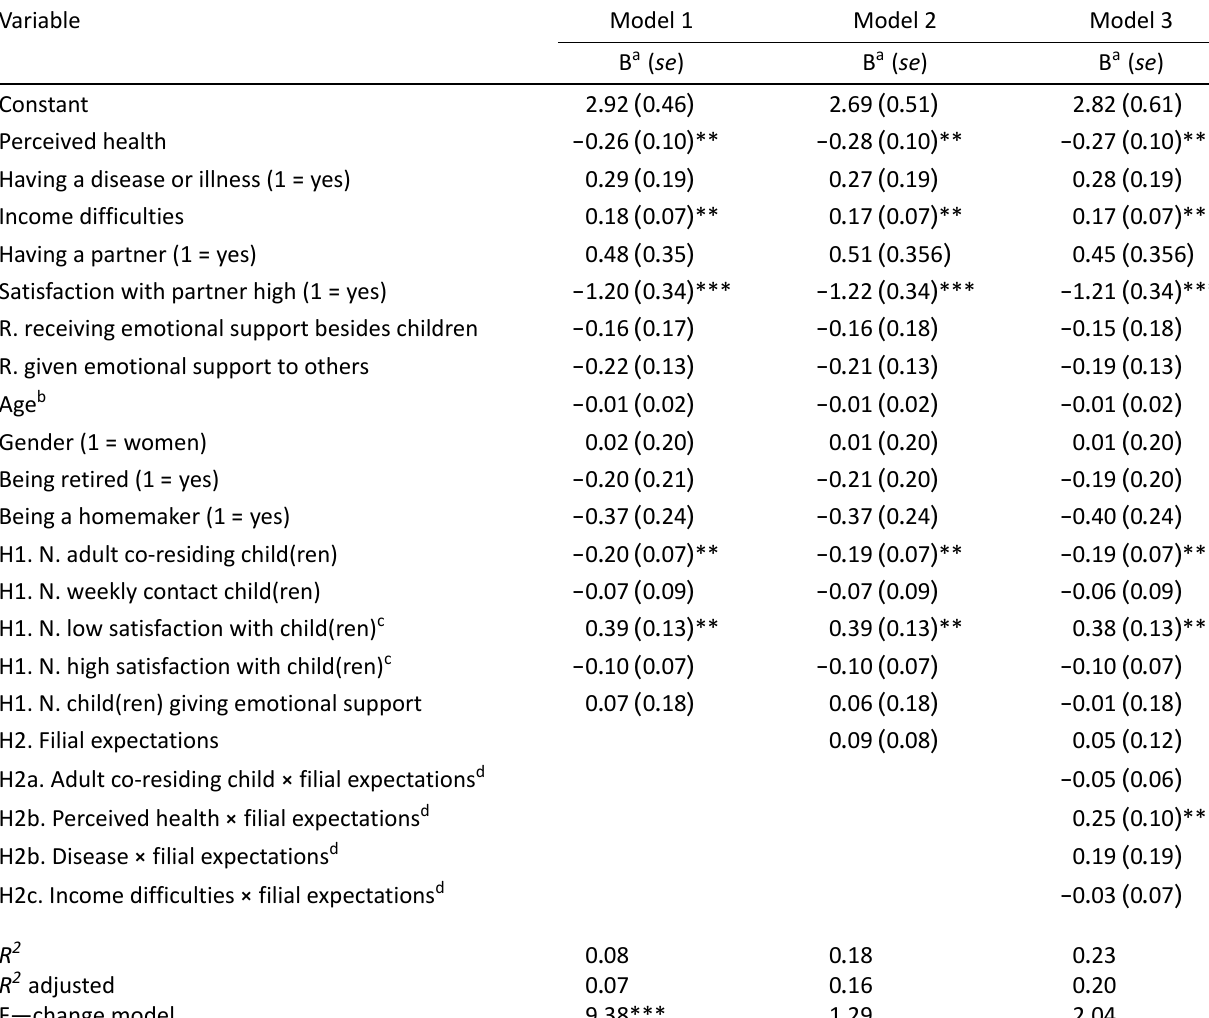
Table 2. Linear regression models for loneliness (n =